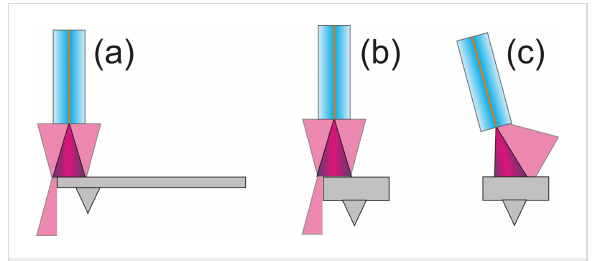
Figure 3: Schematic representation of three common types of misalignment of fiber and cantilever; (a) lateral in length, (b) to the side and (c) tilt of the fiber with respect to the cantilever.